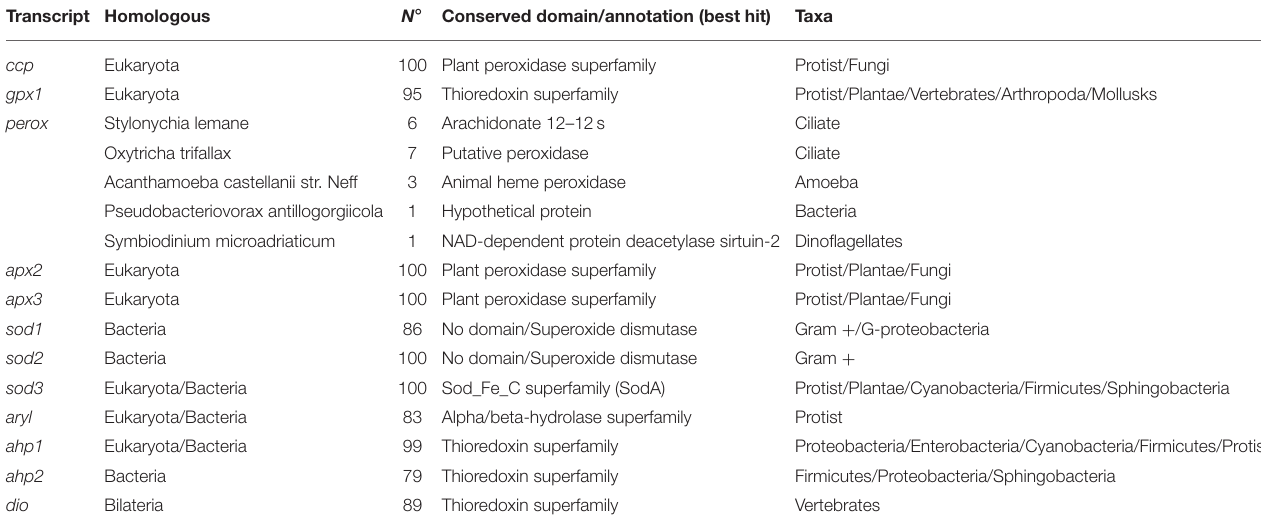
TABLE 3 | Homologous sequences to transcripts selected for PCR studies.